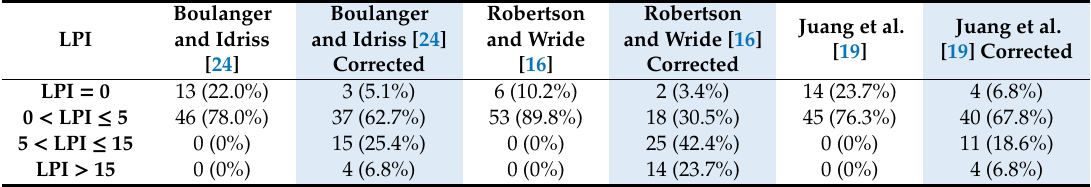
Table 8. Liquefaction severity classes for the macro-area of the Lucca plain (CPTs with depth ≥ 10 m).